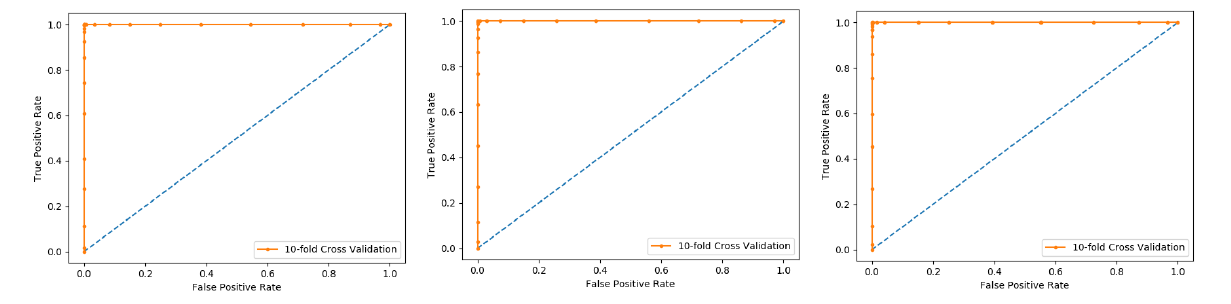
Figure 6. 10-fold Random Forest ROC curve.